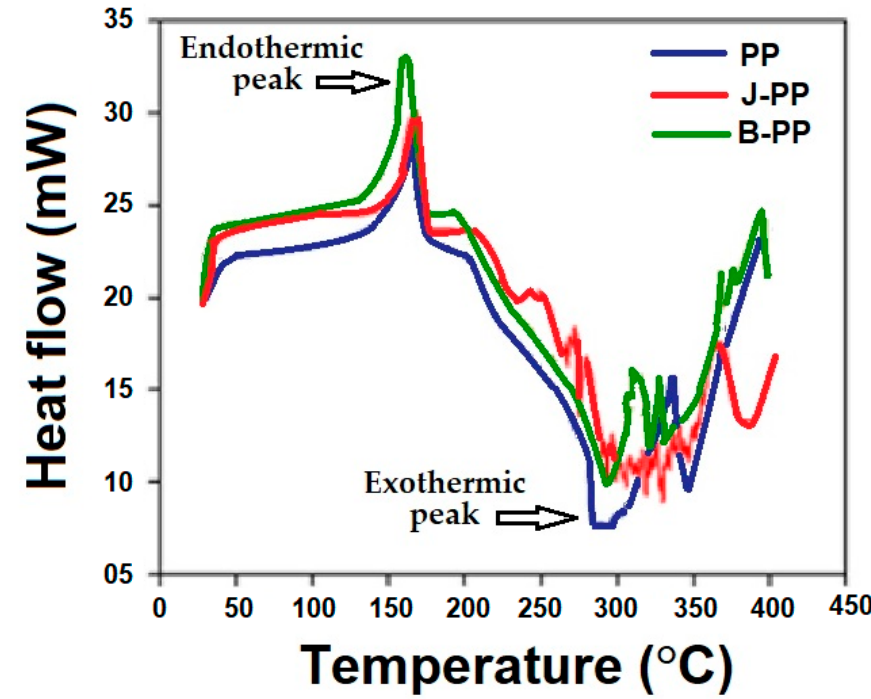
Figure 7. The DSC analysis of the composites.